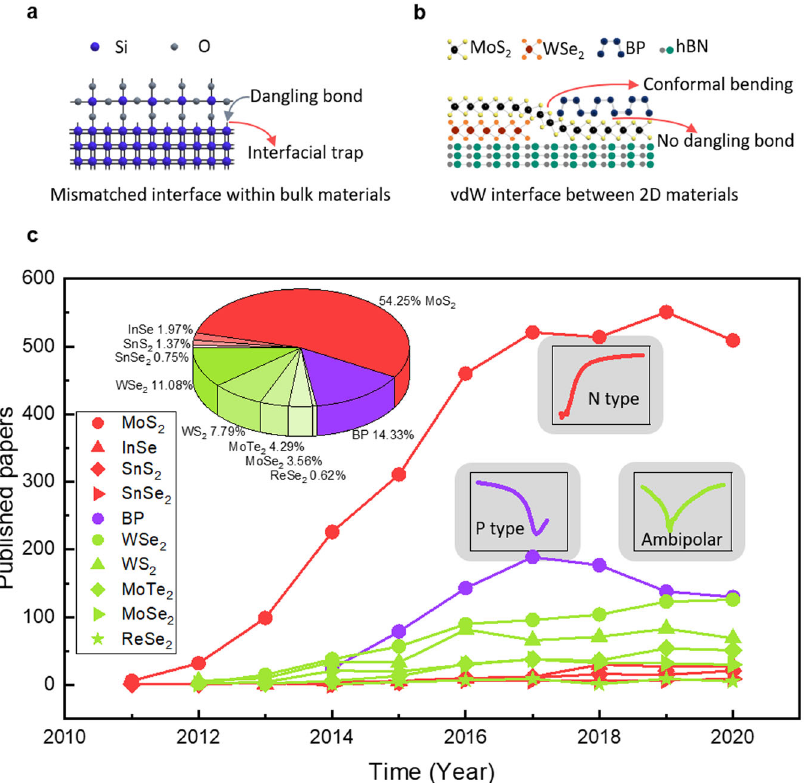
Fig. 2 Structural characteristics and publication trends for 2D semiconductors. a Schematic illustrations of the lattice-mismatched silicon- oxide interfaces. b Schematic illustrations of the lattice-mismatch-free vdW interfaces between 2D materials. c Number of 2D semiconductors publications from 2011 to 2020. (Keywords used for searching “ transistor ” and the corresponding abbreviation for 2D semiconductors like “